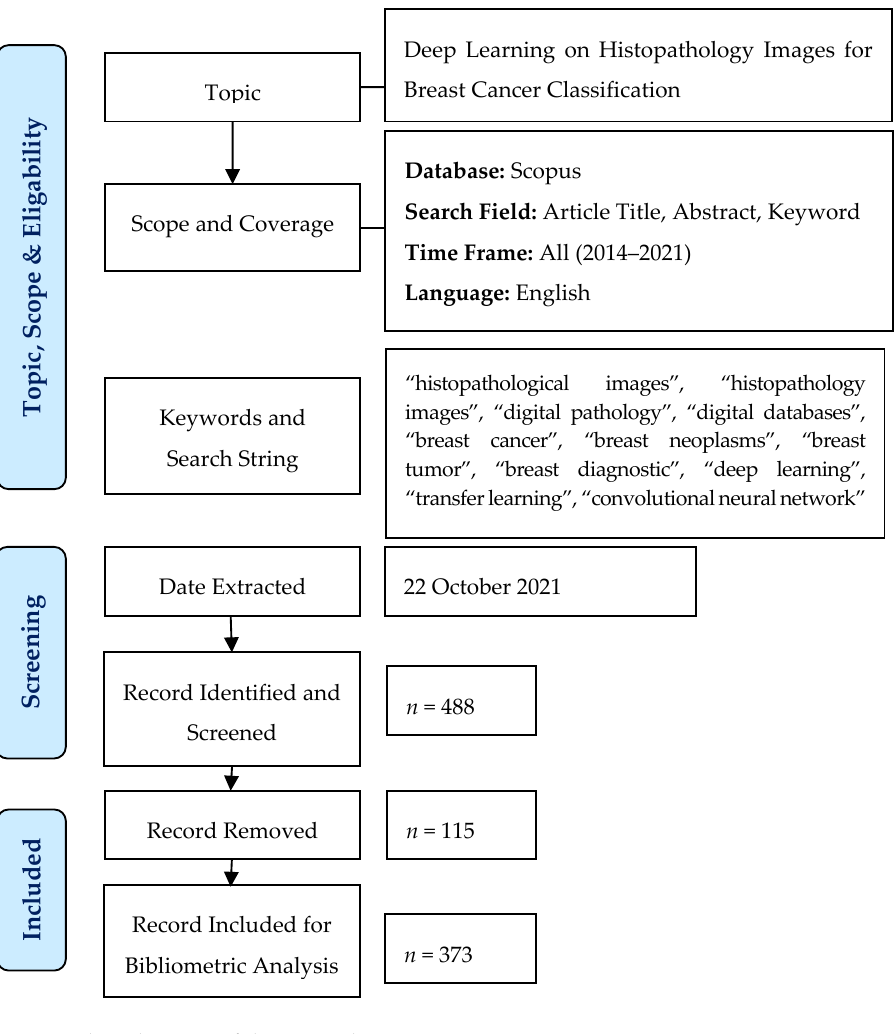
Figure 1. Flow diagram of the research process.